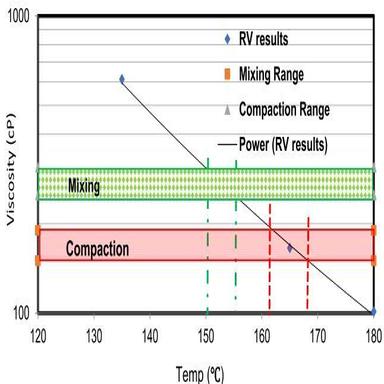
A typical Viscosity vs. Temperature chart.